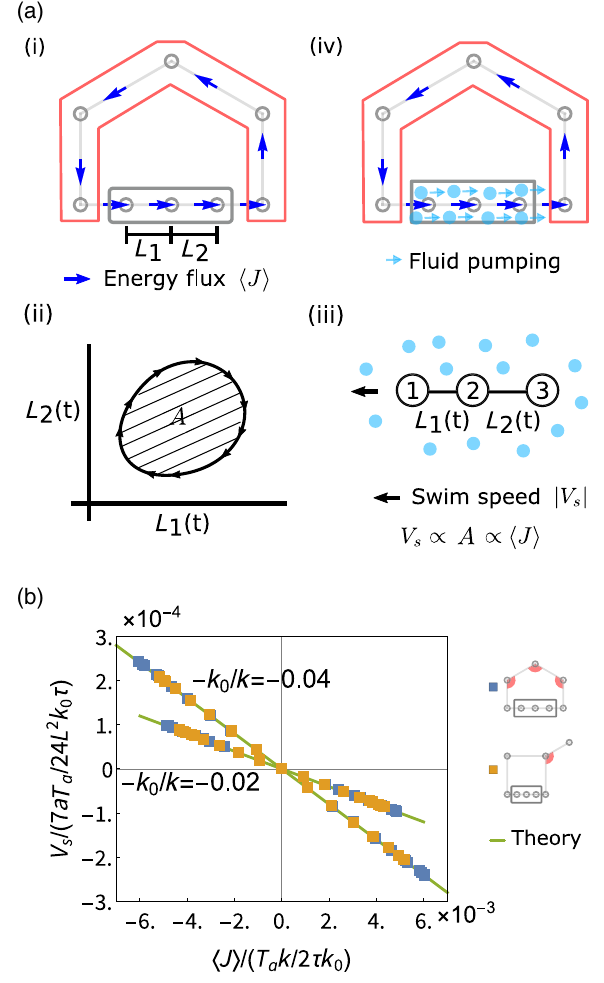
FIG. 5. Utilization of nonequilibrium gyroscopic dynamics to power swimming and pumping in low Re media. (a) The energy flux in the active gyroscopic network is accompanied by nonreciprocal motions of the particles (i,ii). The nonreciprocal motion is a schematic for illustration purposes, and the real data are much noisier. Using these nonreciprocal motions as input, a three-bead linear object can be made to swim through a low Re medium (iii). Finally, by immersing the passive segment into a low Re fluid, the nonreciprocal motions can be used to pump the fluid. In this manner, the energy fluxes can be rectified for is locomotion and force generation (iv). (b) Swim speed V s proportional to the energy flux h J i in the active network. The proportionality constant is − k 0 =k , which is independent of the network geometry. The series of dots for each − k 0 =k are obtained by varying the angles labeled by red disk sectors in pentagon networks or “ square þ tail ” networks. The parameters chosen for 0 . 1 , τ ¼ 1 , k ¼ 5 for the numerical calculations are m , k g ¼ k 0 =k ¼ 0 . 04 and k ¼ 10 for k 0 =k ¼ 0 . 02 . For the active part, γ ¼ 0 . 1 , ˆ B , T 1 . For the passive segment, γ , ˆ B , T 0 a ¼ a ¼